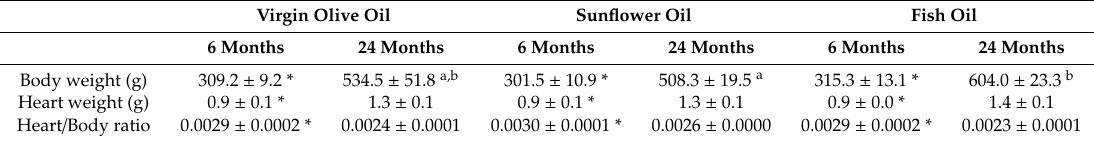
Table 2. Bodyweight (g), heart weight (g) and heart weight / body weight ratio of rats fed for 6 or 24 months on virgin olive oil or sunflower oil or fish oil.